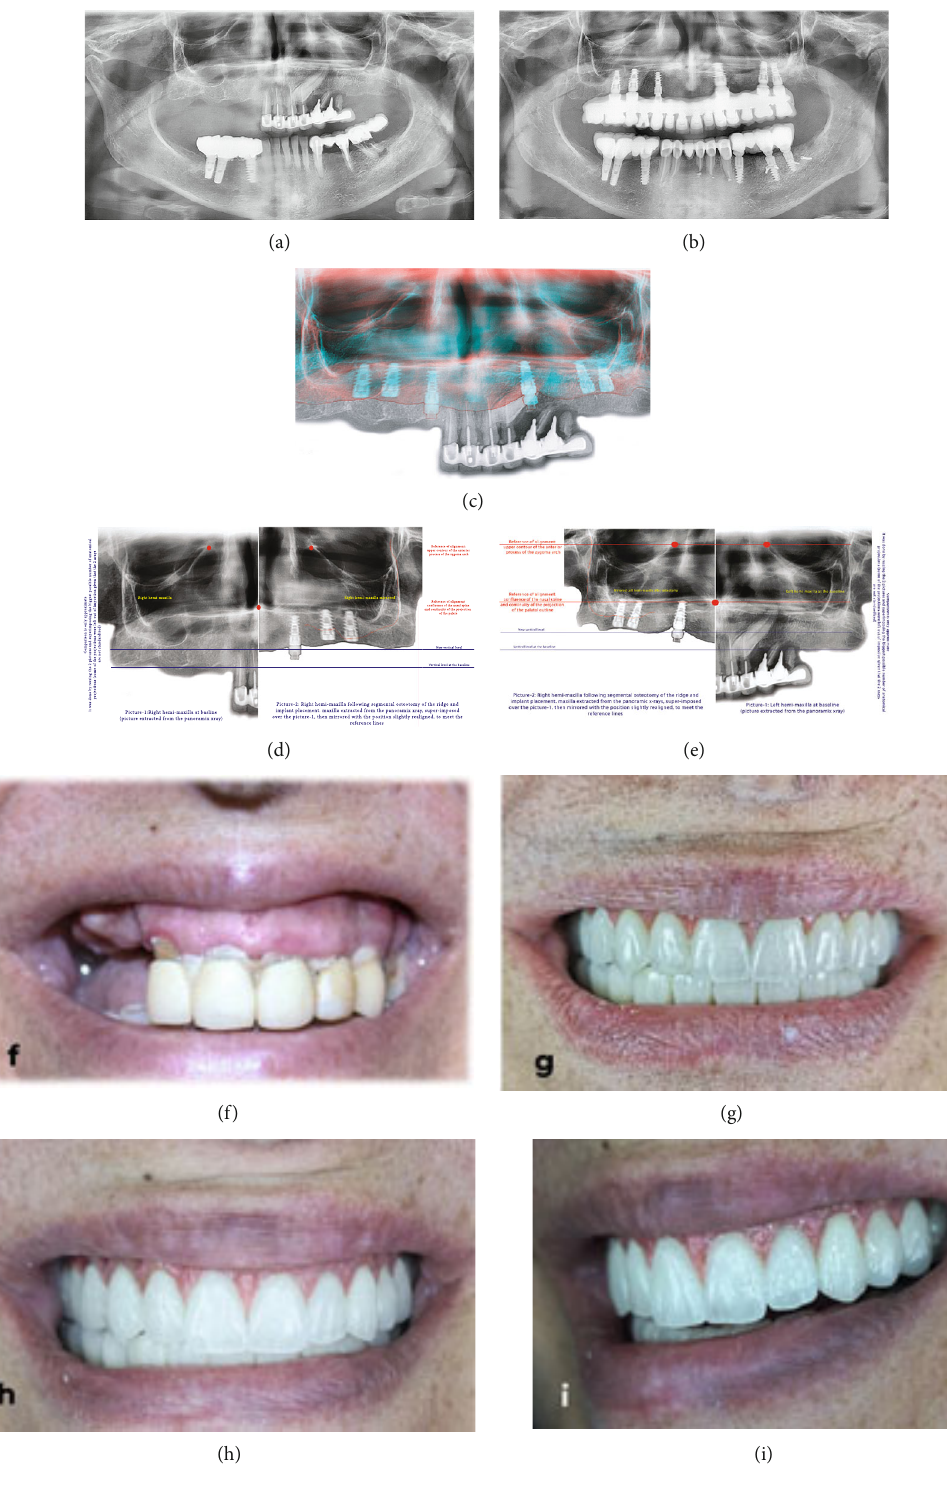
Figure 8: Comparisons. (a, b) Panoramic x-rays at the baseline and after case completion, respectively. (c) 2 overlayed maxillary x-rays, extracted from their respective panoramic (before and after segmental osteotomy) and superimposed to show the approximate di ff erence between the baseline and the actual vertical level of the maxillary process. (d, e) Comparison between the baseline and after osteotomy showing the vertical translation of the maxilla in an upward direction. (f, g) Pictures revealing maximum smile at the baseline and after case completion, respectively. (h, i) Additional pictures showing the fi nal